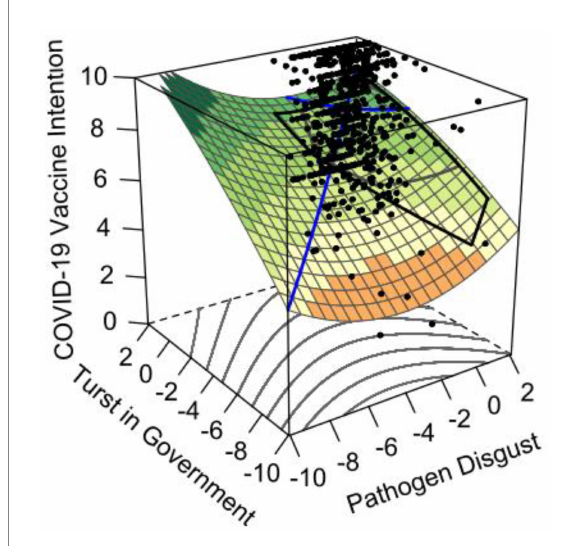
FIGURE 2 Response surface plot of pathogen disgust, trust in government, and COVID-19 vaccine